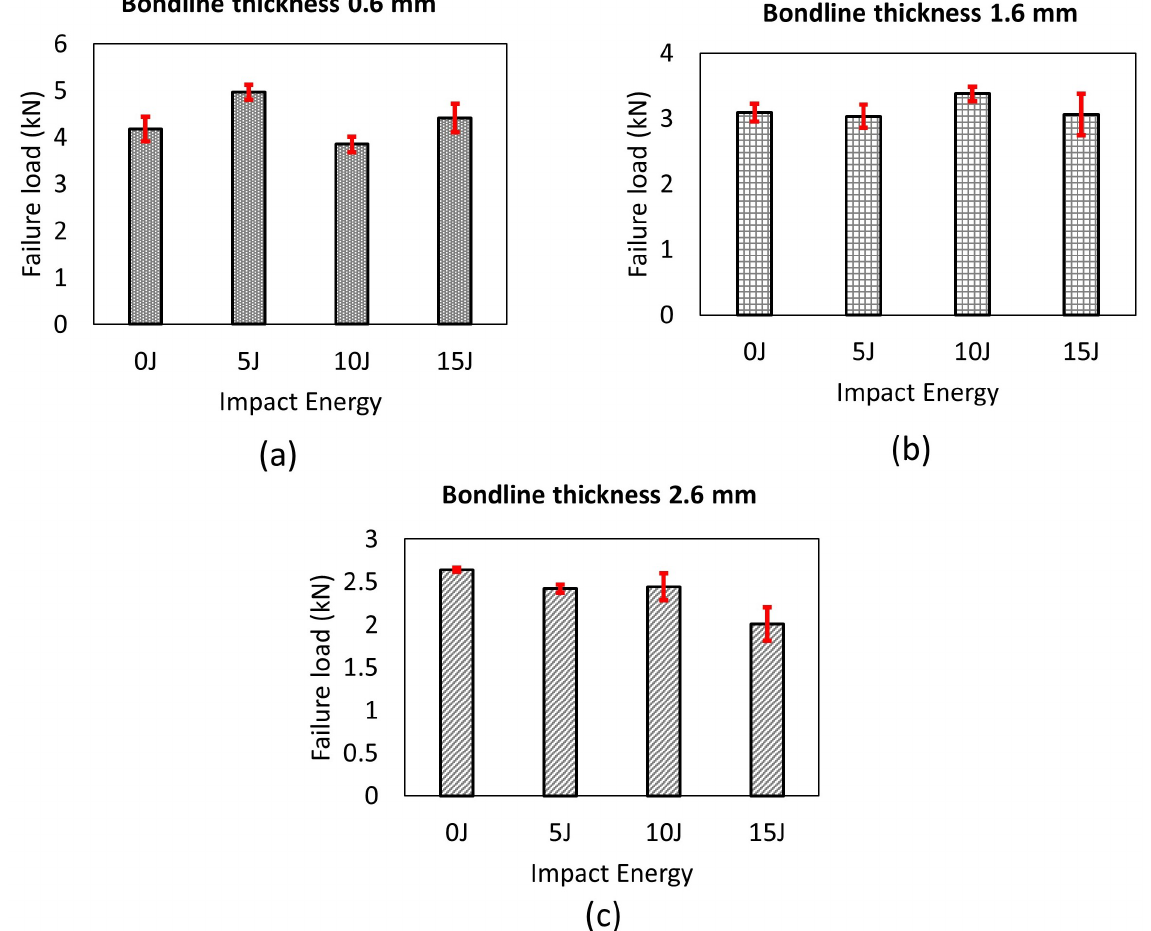
Figure 22. Comparison of post impact failure load of joints after being subjected to different impact energy: ( a ) Bondline thickness of 0.6 mm, ( b ) bondline thickness of 1.6 mm, and ( c ) bondline thickness of 2.6